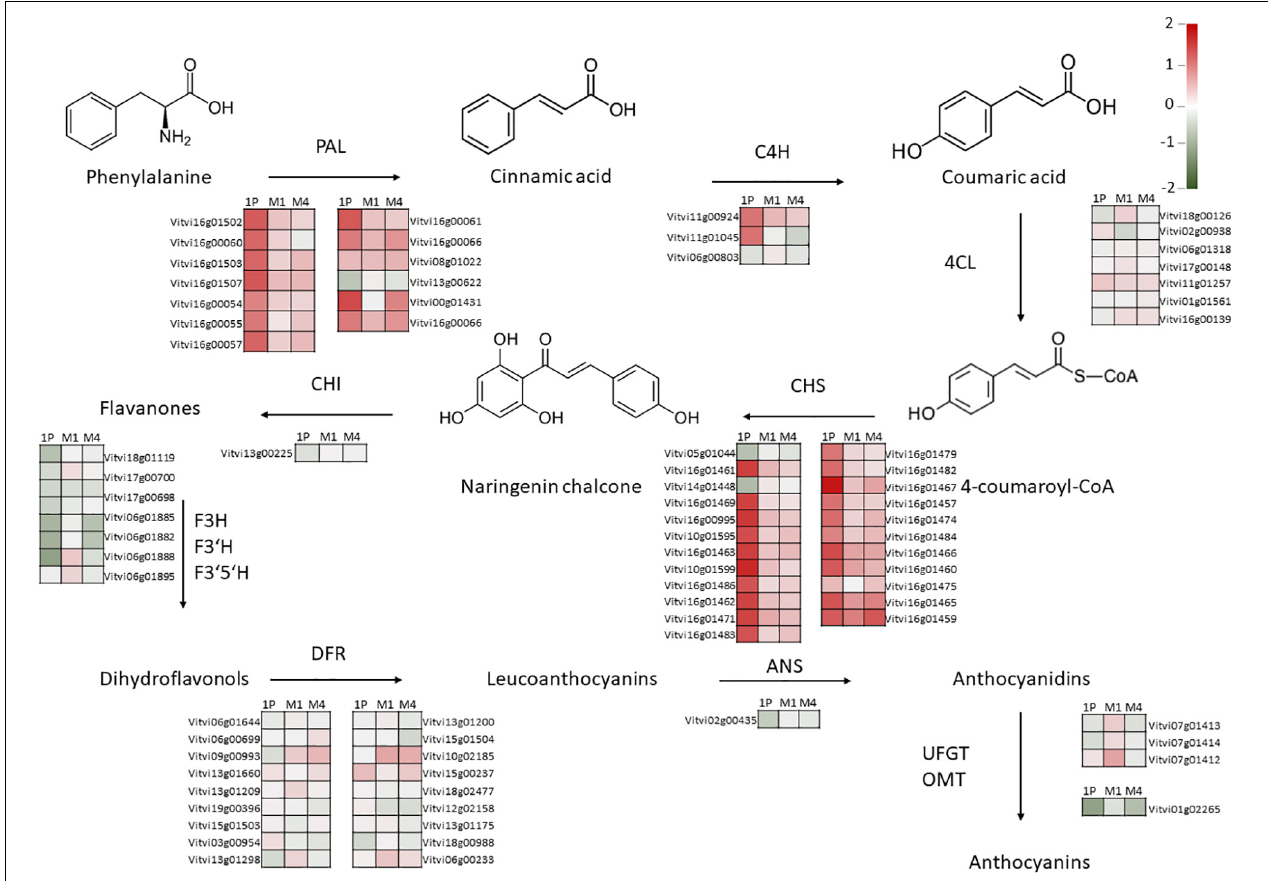
FIGURE 4 | Log 2 FC values of genes involved in anthocyanin synthesis in Tempranillo in salinity-treated berries as compared to controls grafted onto 1103-Paulsen, M1, and M4. The specific gene names are provided by means of the Vitvi identifiers. Color represents the value of Log 2 FC. PAL – phenylalanine ammonia-lyase; C4H, cinnamate-4-hydroxylase; C4L, 4-coumarate: CoA ligase; CHS, chalcone synthase; CHI, chalcone-flavanone isomerase; F3H, flavanone 3-hydroxylase; F3 (cid:48) H, flavonoid 3 (cid:48) -hydroxylase; F3 (cid:48) 5 (cid:48) H, flavonoid 3 (cid:48) 5 (cid:48) -hydroxylase; DFR, dihydroflavonol 4-reductase; ANS, anthocyanin synthase; UFGT, anthocyanidin 3- O -glucosyltransferase; OMT, O -methyltransferase; 1P, 1103-Paulsen rootstock; M1, M1 rootstock; M4, M4 rootstock.